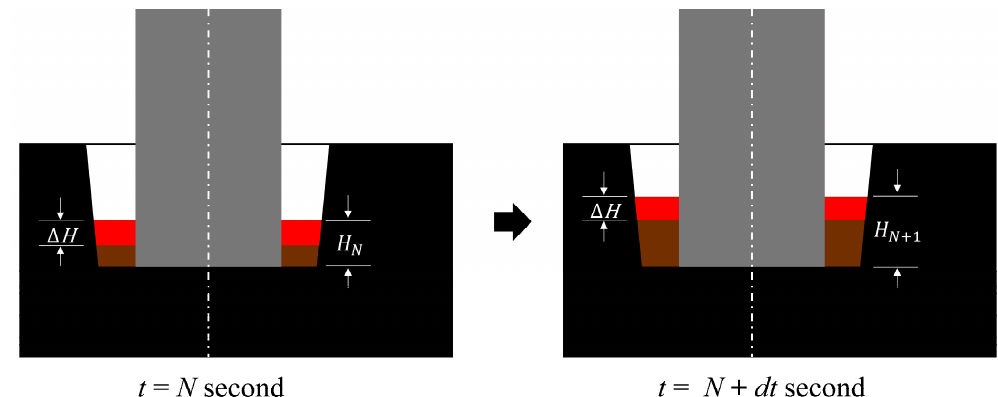
Figure 8. The schematic picture of the loads.